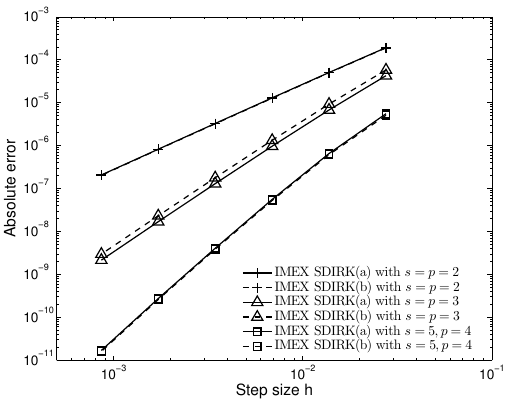
Figure 10. Absolute error vs. step size for the van der Pol equation with ε = 10 − 1 using IMEX SDIRK methods. ‘a’ or ‘b’ indicate that the corresponding IMEX SDIRK method has maximal stability region of the explicit part or maximal stability region of the IMEX method respectively.